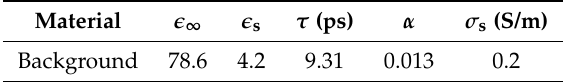
Table 2. Material parameters used to simulate the higher permittivity background material, similar to normal